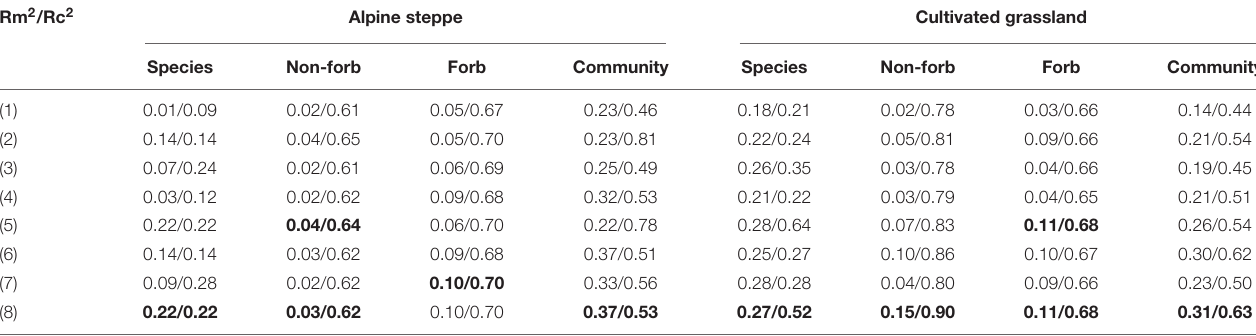
TABLE 3 | The pseudo-R 2 of the linear mixed models of plant height and community weighted mean value of height in alpine steppe and cultivated grassland. Rm 2 /Rc 2